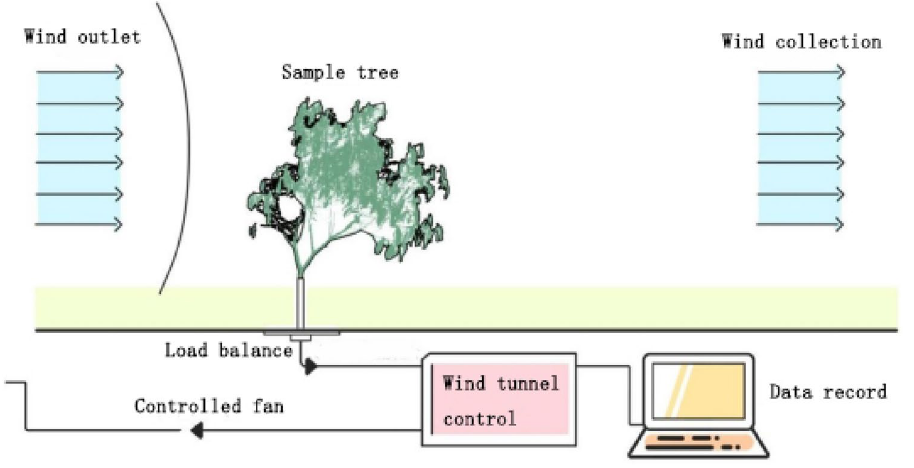
Figure 2. Schematic diagram of wind tunnel